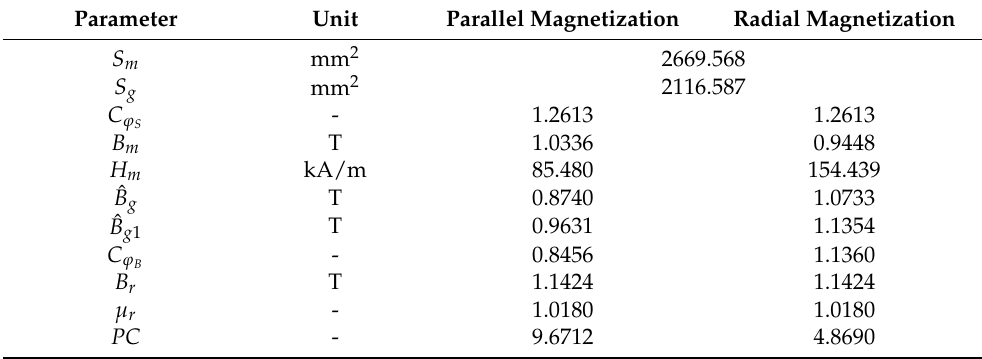
Table 4. Surface areas and magnetic properties of a single banana layer